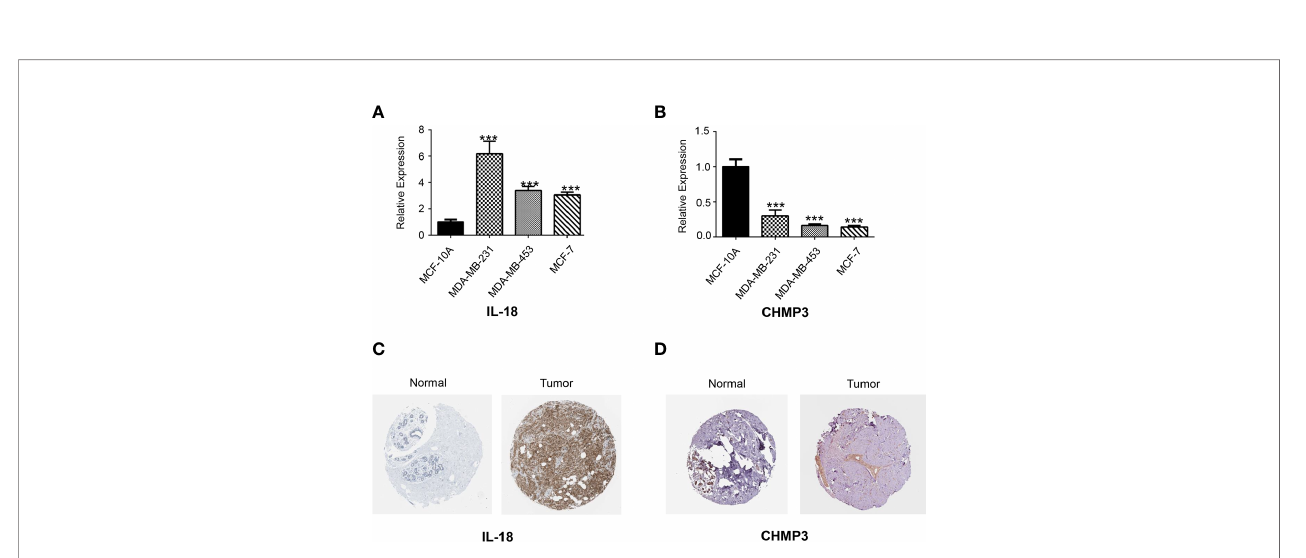
FIGURE 10 | Real-time qPCR and HPA analysis. The expression of two candidate PRGs including IL-18 (A) and CHMP3 (B) in both normal breast cell line (MCF-10A) and breast cancer cell lines (MDA-MB-231, MDA-MB-453 and MCF-7) were checked by qPCR analysis. IHC staining for IL-18 (C) and CHMP3 (D) from HPA